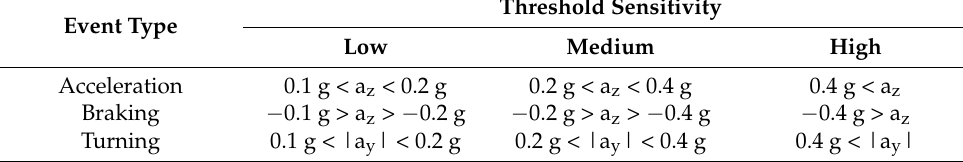
Table 1. Event thresholds